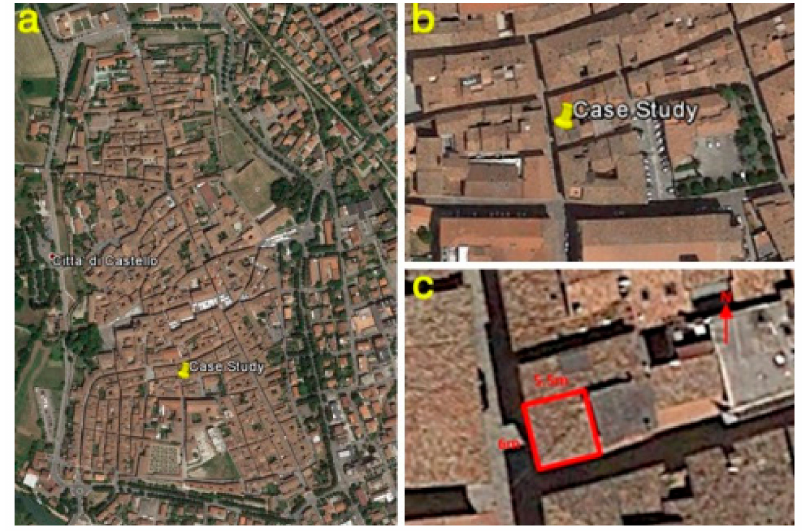
Figure 4. Aerial view of the historical centre and the case study building: ( a ) historical centre and case study; ( b ) case study area; ( c ) case study